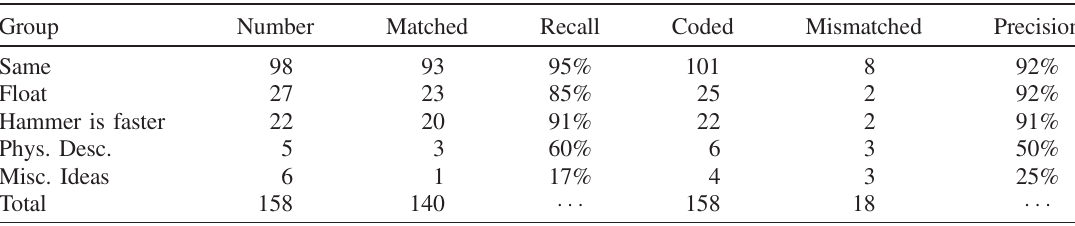
TABLE VI. Group-by-group matching for the hammer and feather on the moon activity.